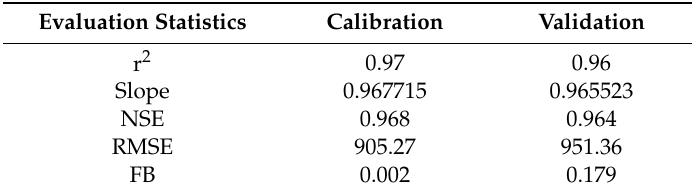
Table 4. Model evaluation statistics during calibration and cross-validation when predicting the weight of turkeys using the PF of their vocalizations.